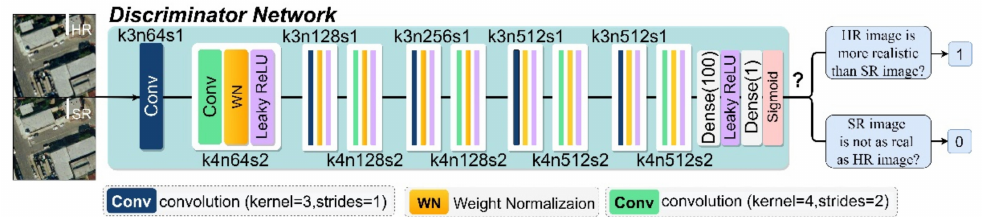
Figure 5. Schemes follow the same formatting. Structure diagram of the discriminator network, k denotes the convolutional kernel size, n denotes the number of convolutional kernel channels, and s denotes the convolutional